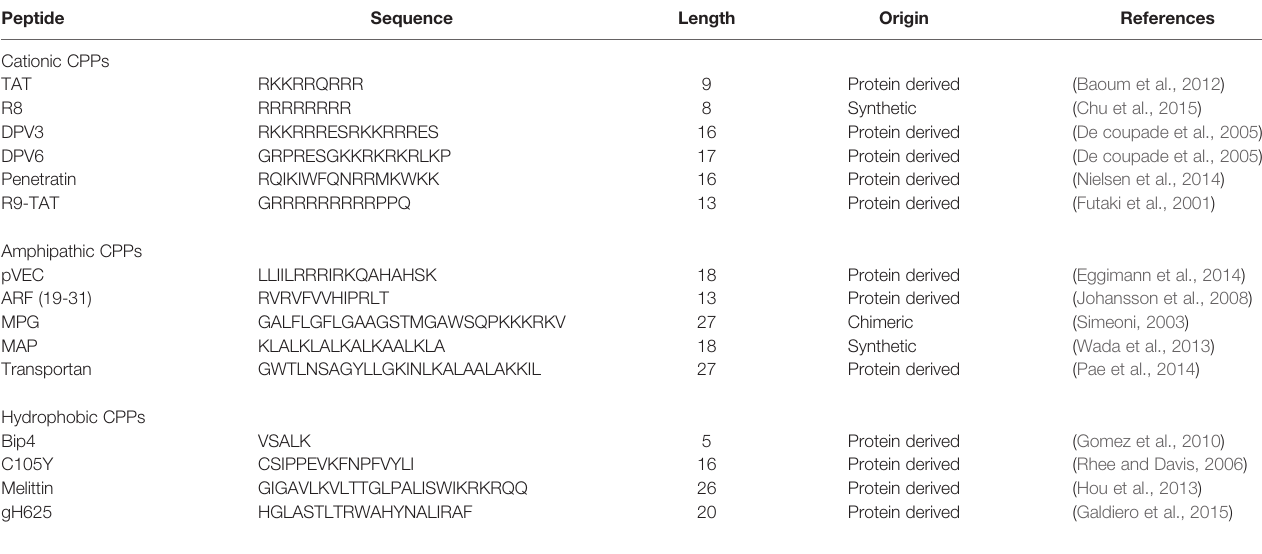
TABLE 1 | Classi fi cation of the types of CPPs.